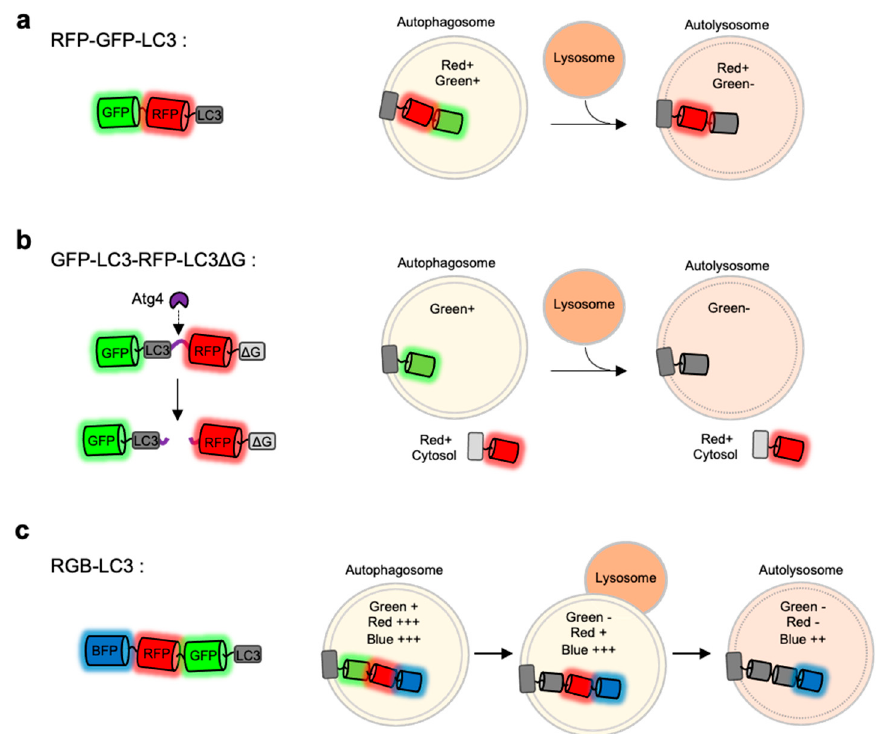
Figure 3. Monitoring of autophagy progression by tandem or triple FPs with different pH-sensitiv- ity ( a ) RFP-GFP-LC3 is a tandem FP-tagged LC3 sensor consisting a pH-sensitive GFP and a pH-stable RFP. Both green and red signals are expected in autophagosomes, while green signal disappears in autolysosomes. ( b ) GFP-LC3-RFP-LC3 ∆ G is composed of GFP-LC3 and RFP-LC3 ∆ G linked by a substrate for an autophagy initiating protease Atg4. When autophagy is induced, the activated Atg cleaves the substrate, generating GFP-LC3 and RFP-LC3 ∆ G. The released GFP-LC3 can be localized at autophagic vesicles, while the RFP-LC3 ∆ G remains in the cytosol serving as an internal control for GFP-LC3. ( c ) Red-green-blue-LC3 (RGB-LC3) is composed of three colors of FPs with different pH-sensitivity: a highly pH-sensitive superecliptic pHluourin (SEP, pKa = 7.2), a pH-stable mTagBFP2 (pKa = 2.7), and mApple (pKa = 6.5) with intermediate pKa and pH-sensitivity. The RGB-LC3 sensor allows for the monitoring of different stages of autophagy.